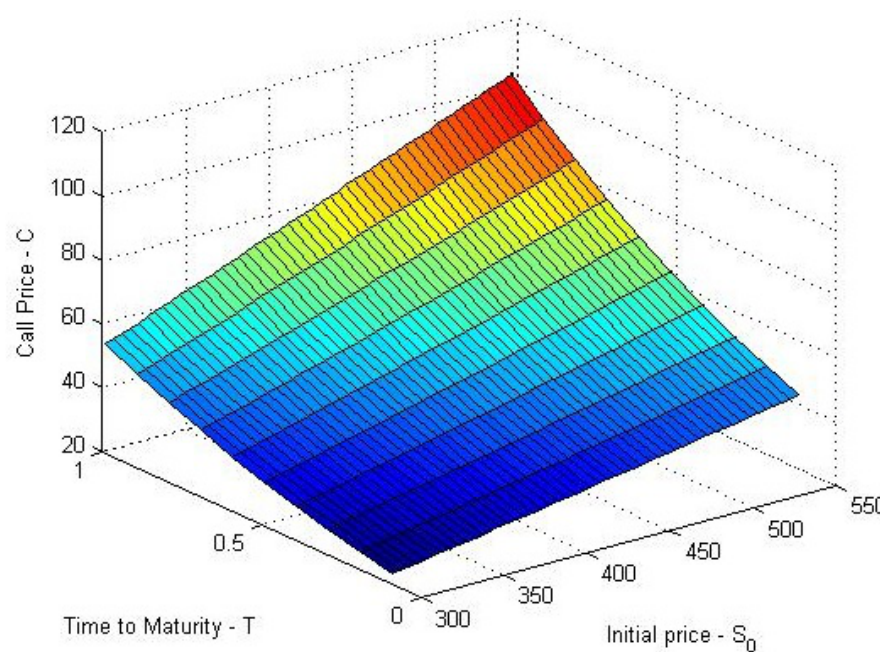
Figure 3. Down-And-Out call with CGMY( C = 0 . 0244 , G = 0 . 0765 , M = 7 . 5515 , Y = 1 . 2945 ) with Stock Price S 0 = 450, Strike price K = 150, Barrier B = 350, σ = 0.1812, r = 0.167 and Time to maturity T = 1.1.